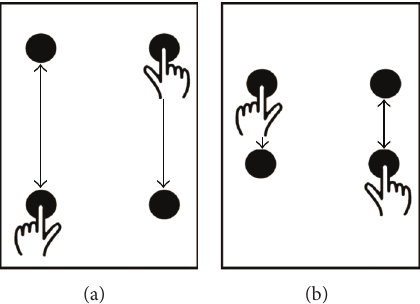
Figure 1: Schematic of targets and movements for the bilateral, alternating upper extremity task. Baseline (left, 10cm); Small (right, 5